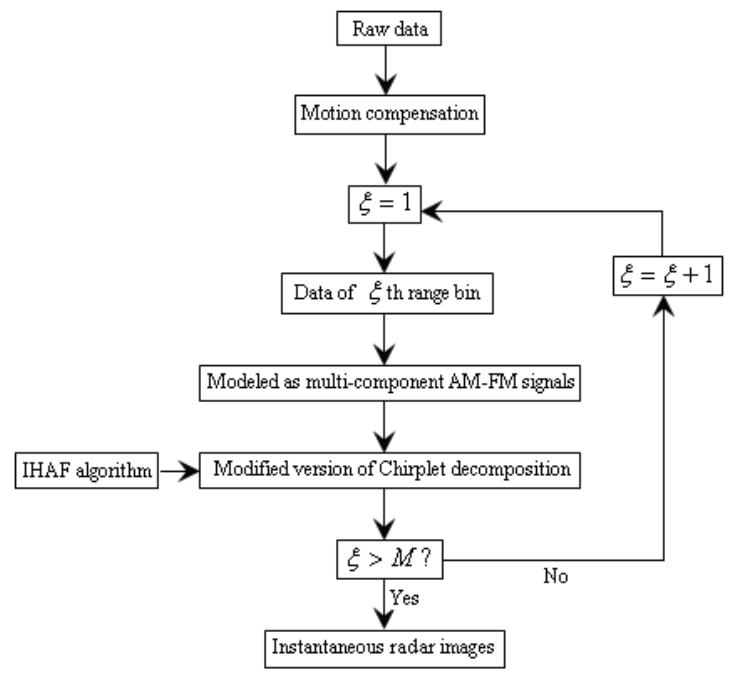
Figure 4. Flowchart of radar imaging algorithm in this paper.